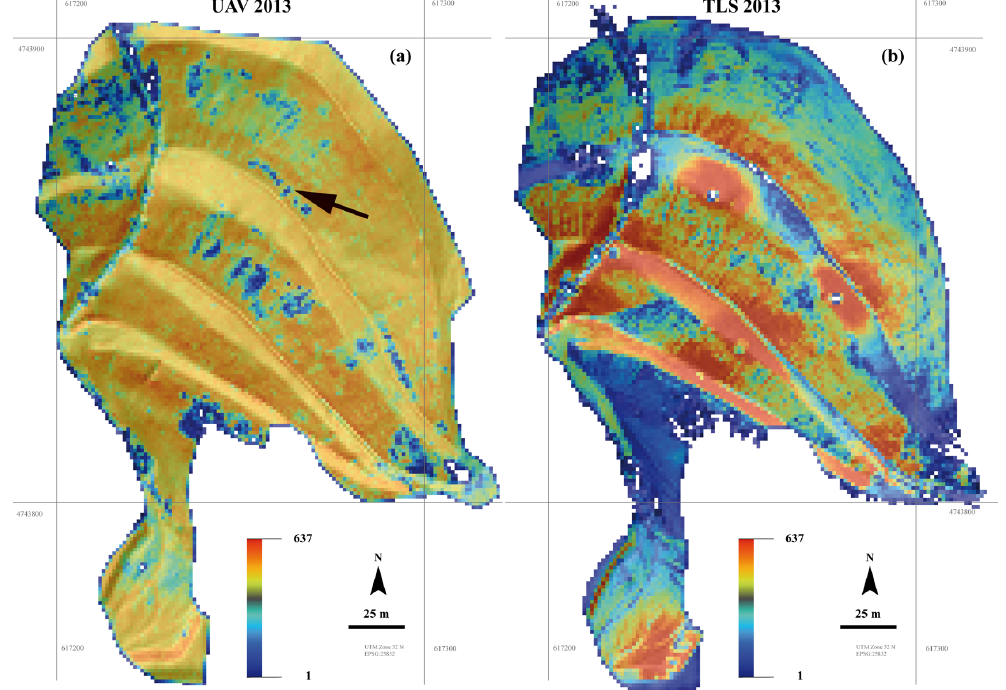
Figure 6. Comparison of the point density (points per m 2 ) for (a) the 2013 UAV data and (b) the 2013 TLS